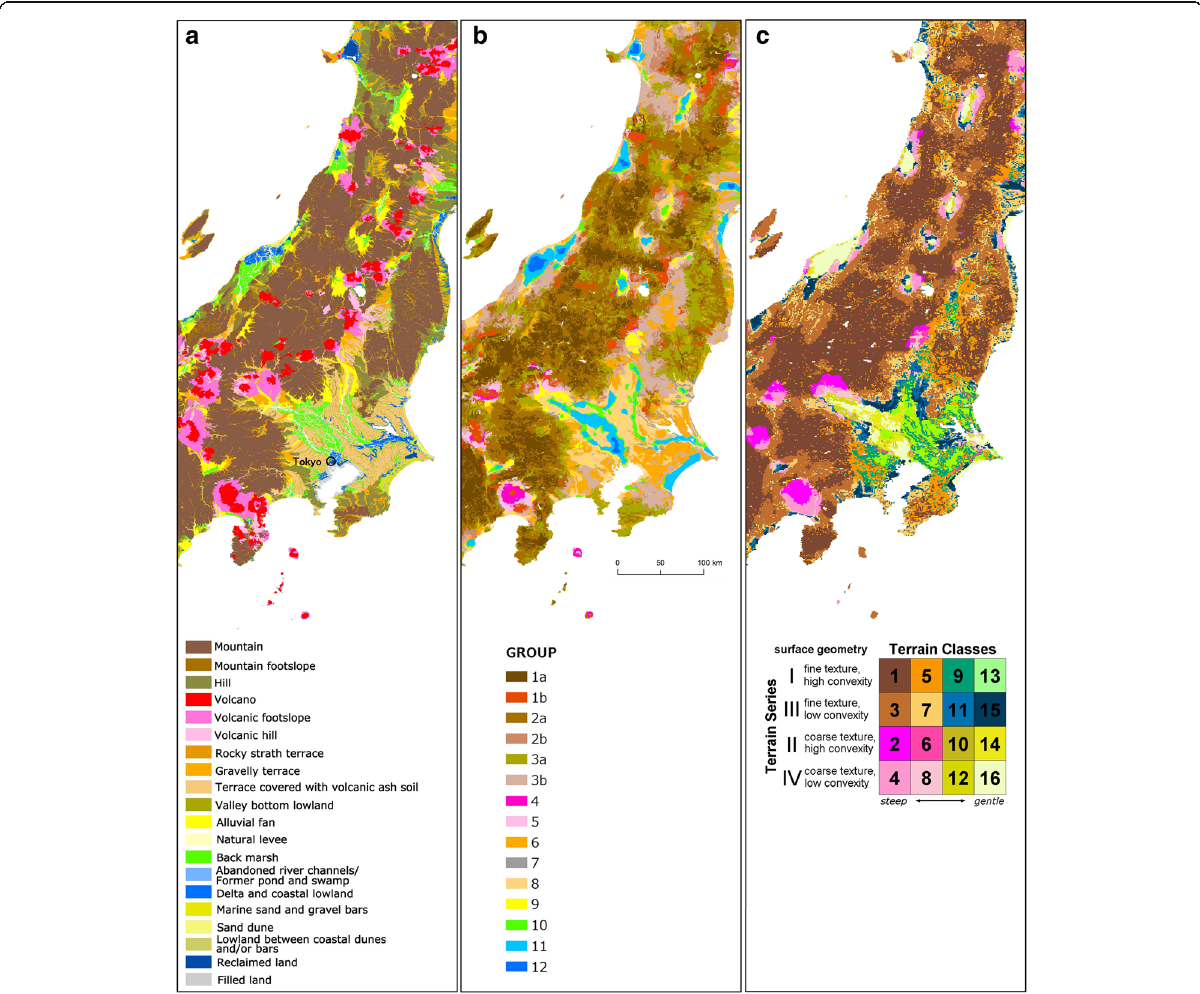
Fig. 14 Comparison of terrain classification images of the Kanto District and its surroundings. a JEGM (Wakamatsu and Matsuoka 2013). b Results of this study, using the 280 m DEM. c Iwahashi and Pike (2007), using a 1 km